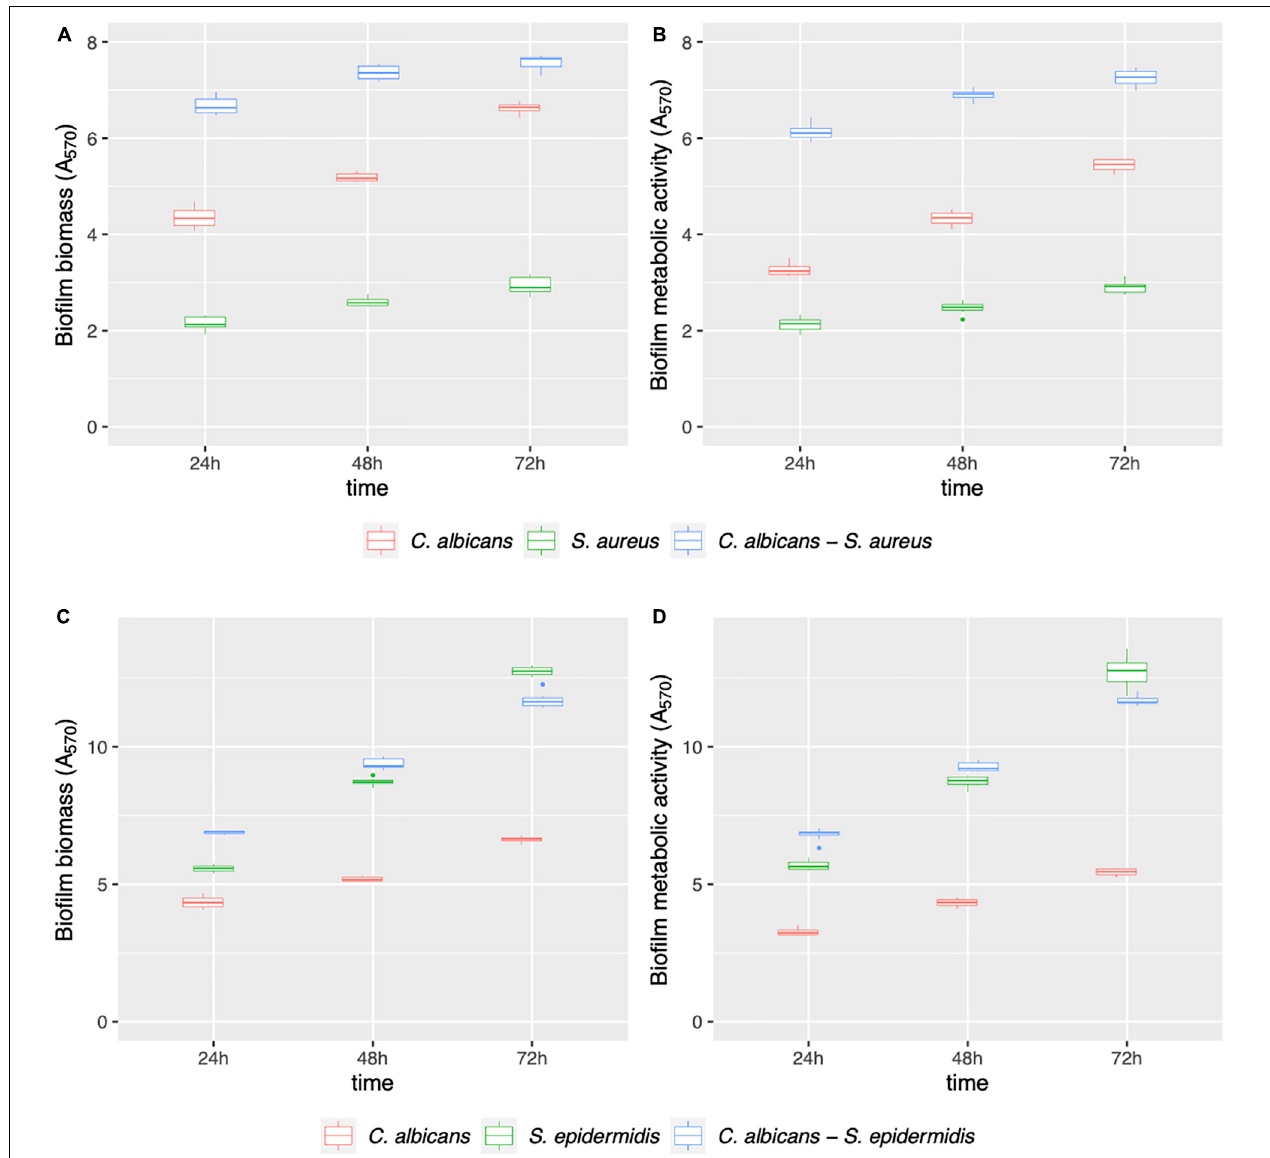
FIGURE 2 | Mono- and dual-species C. albicans – Staphylococcus spp. biofilm formation on silicone discs. Biofilms were evaluated in terms of biofilm biomass (A,C) and biofilm metabolic activity (B,D) at 24, 48, and 72